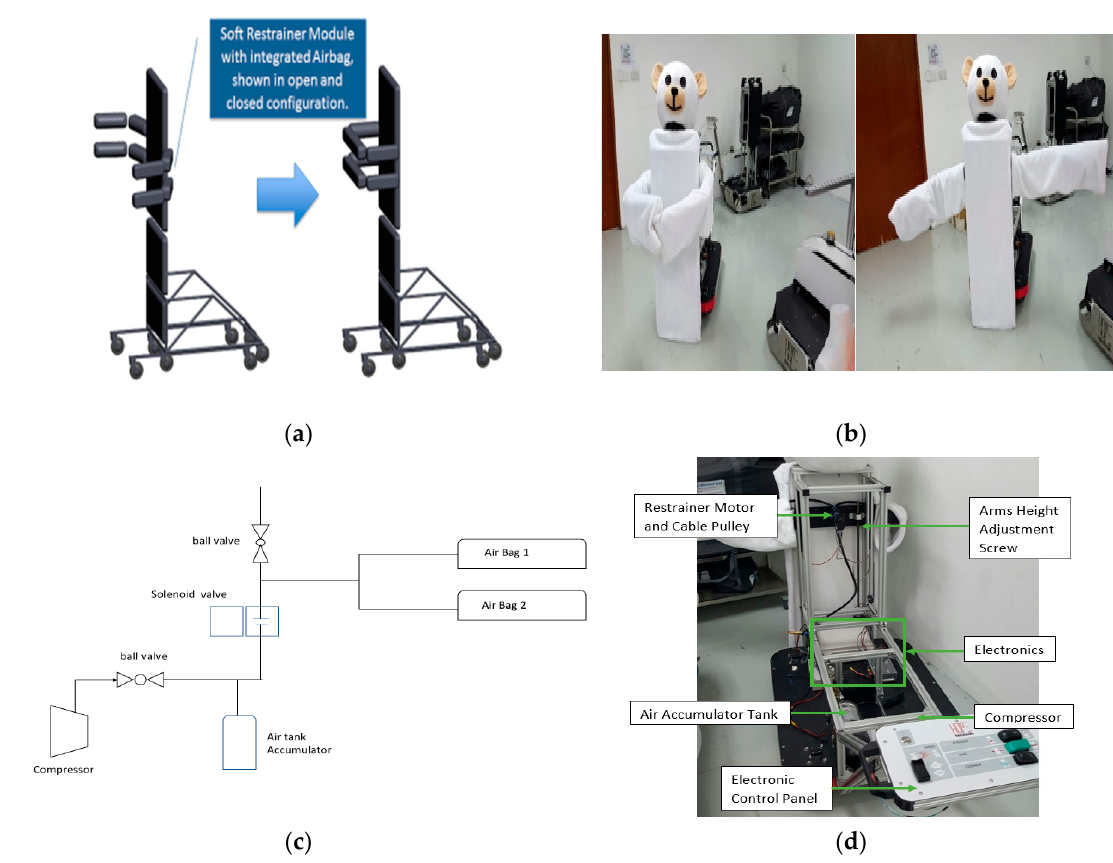
Figure 5. Restraint module of experimental model, IMOVE-0. ( a ) Restraint module comprising of dual restraint arm and arm air-bags. ( b ) Photo of the Arms Open and Close Position in the experimental model. ( c ) Schematic diagram of the pneumatic system in the dual air-bags. ( d ) Structure of the restraint motor and pneumatic system.